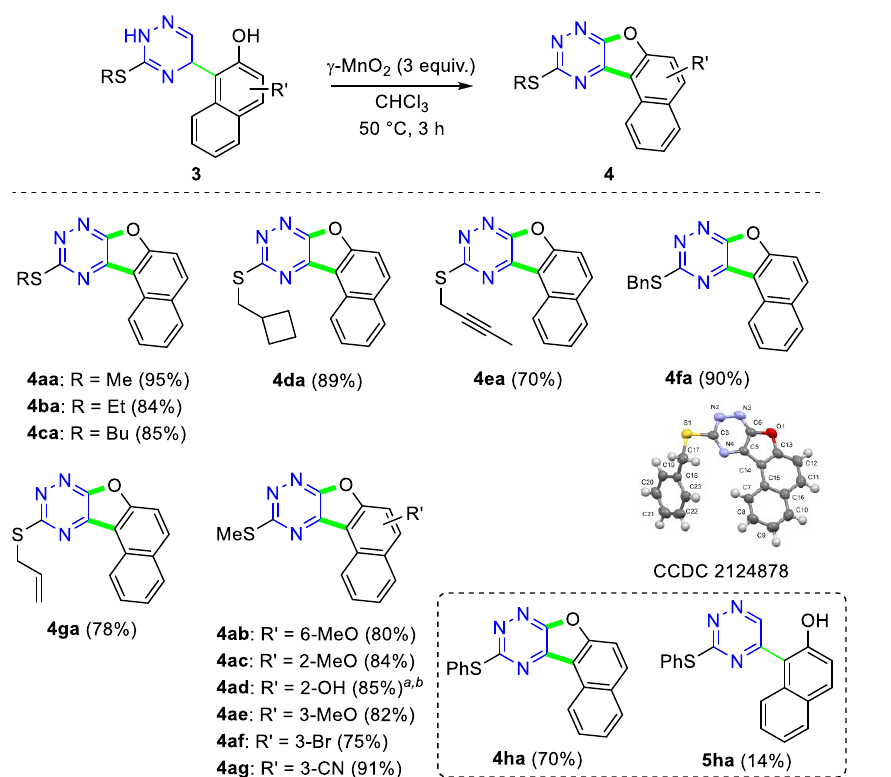
Scheme 5. Substrate scope for the synthesis of benzofuro-fused 1,2,4-triazines 4. Reaction conditions: 3 (0.2 mmol), γ-MnO 2 (0.6 mmol) in CHCl 3 (3 mL), 50 °C, 3 h. a Two-step yield; b CHCl 3 :EtOH ( v / v = 4:1, 3 mL).